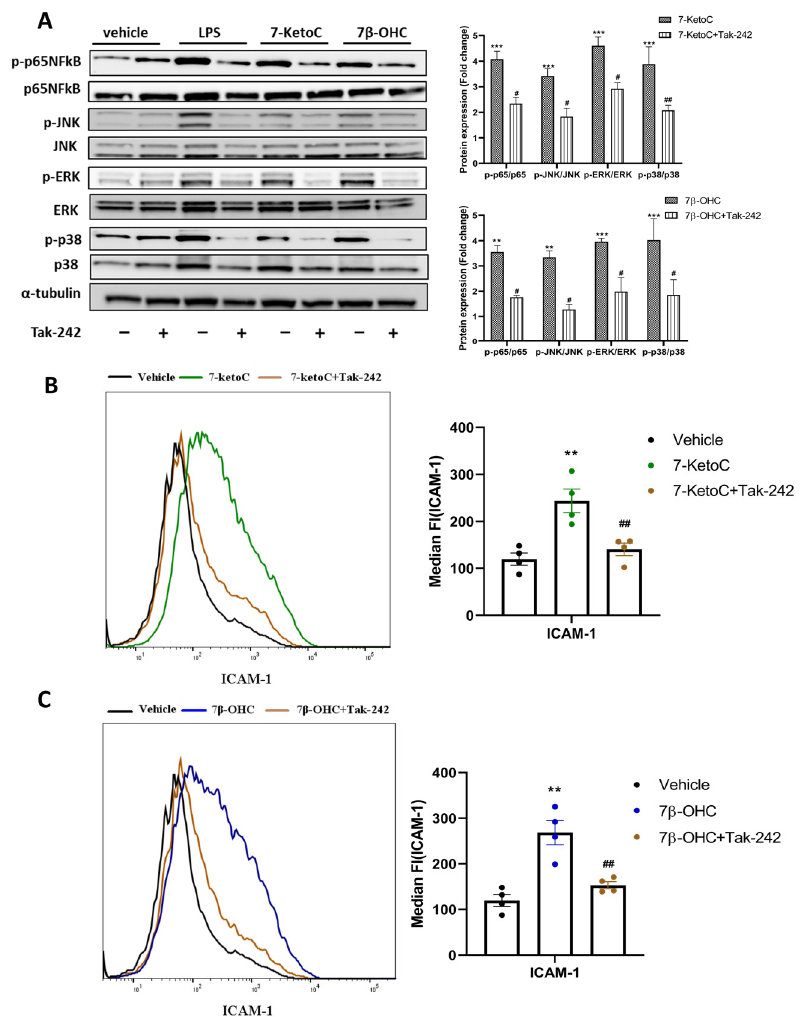
Figure 6. TLR-4 inhibition by Tak-242 ameliorates oxysterol-induced inflammatory responses in fpEC. ( A ) Representative western blot and densitometric analysis showing decreased activation of MAPK proteins, p-65 NF κ B and expression of ICAM-1 in oxysterol-treated fpEC by TLR-4 inhibition ( n = 5) using Tak-242. Target gene fold expression in vehicle is normalized to one (not shown in the graph), and the fold change expression of all targets in treatment groups is relative to the vehicle. ( B , C ) Similar results were also obtained for ICAM-1 surface expression in response to Tak-242, as can be seen from the representative FACS histogram and median fluorescence intensity plot ( n = 4). Data are presented as mean ± SEM. Statistically significant differences between vehicle and oxysterol treatment (indicated with *) and between oxysterol and oxysterol + Tak-242 treatment (indicated with #) were calculated using two-way ANOVA (for phospho-proteins) and one-way ANOVA (for ICAM-1), followed by Tukey’s post hoc test. # p < 0.05, ##/** p < 0.01 and *** p <